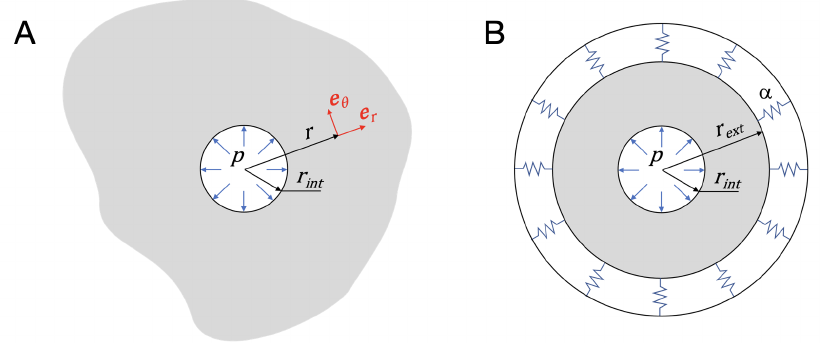
Figure 6. Verification problem. ( A ) Infinite solid with a cylindrical cavity of radius r int subjected to internal pressure p ; ( B ) Infinite cylinder of inner radius r int and external radius r ext subjected to an internal pressure p and elastic bed boundary conditions at r ext